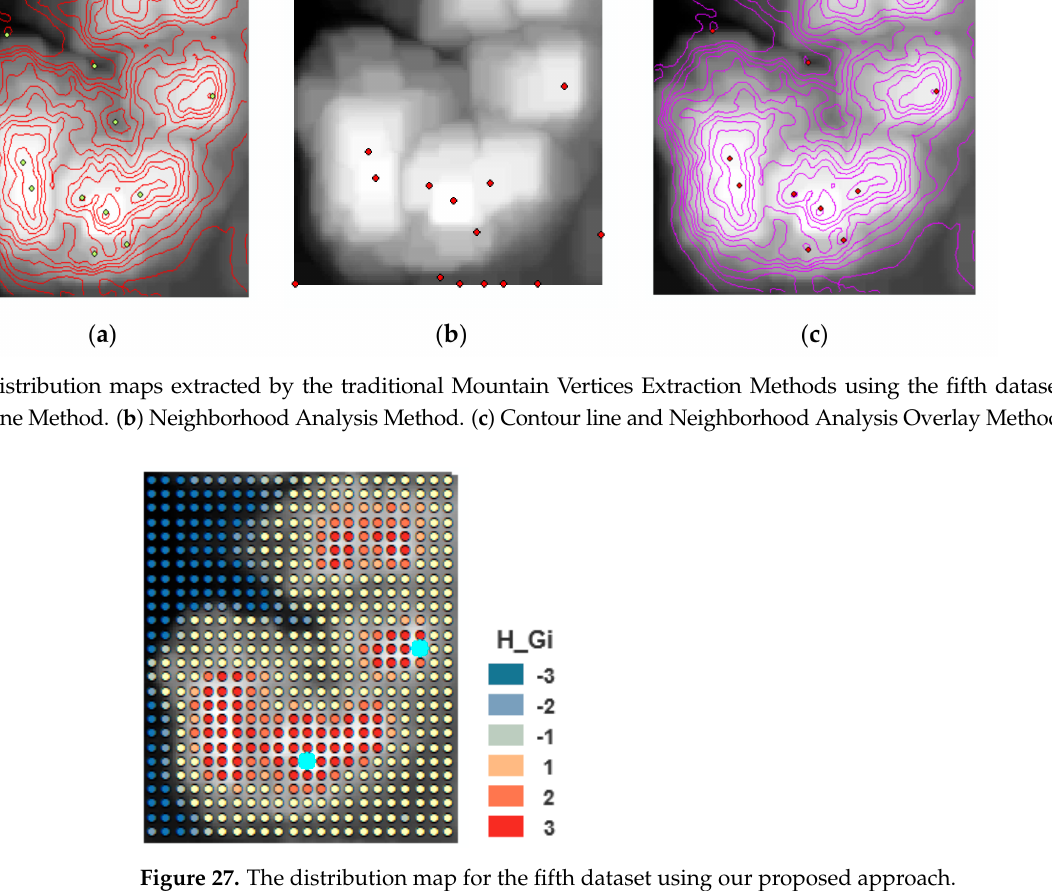
Table 16. The mountain vertices extraction results for each method using the fifth dataset.